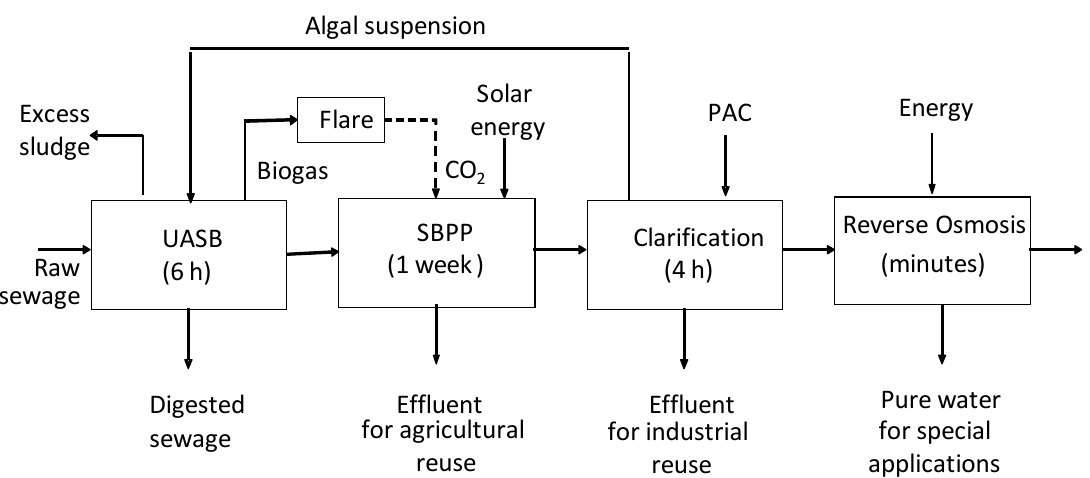
Figure 9. Flow sheet to produce water for industry for general use or to produce demi water for special applications.